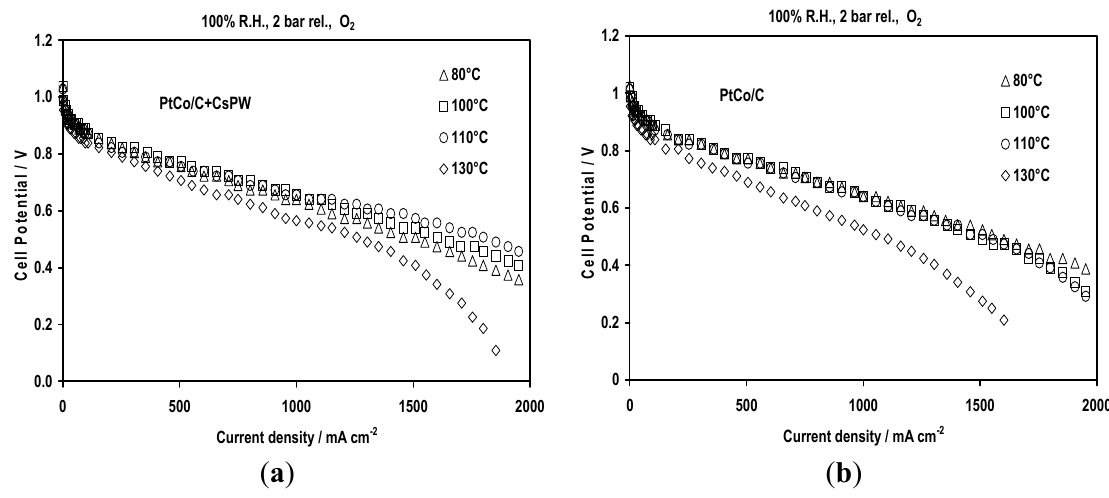
Figure 4. Effect of temperature on the polarization curves of promoter-based ( a ) and the bare ( b ) catalytic layers. 100% R.H., O 2 feed, 2 bar rel.